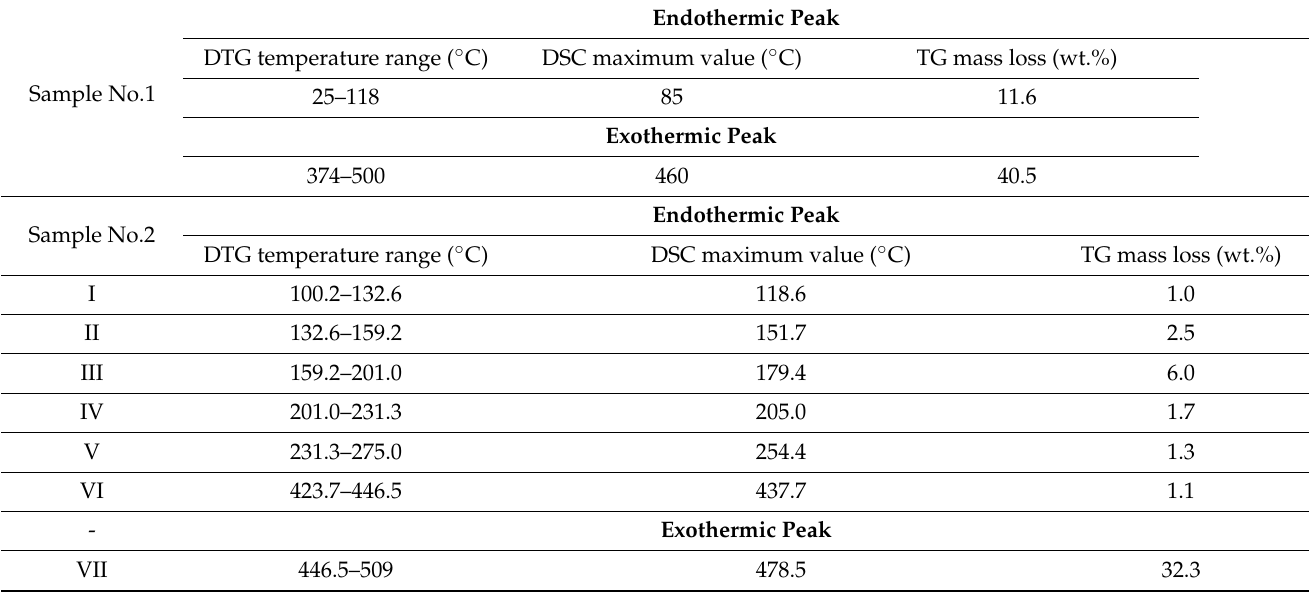
Figure 3. TG/DTG–DSC curves for Tb:2,6-DClB. Table 2. TG/DTG–DSC data for sample No. 1 and